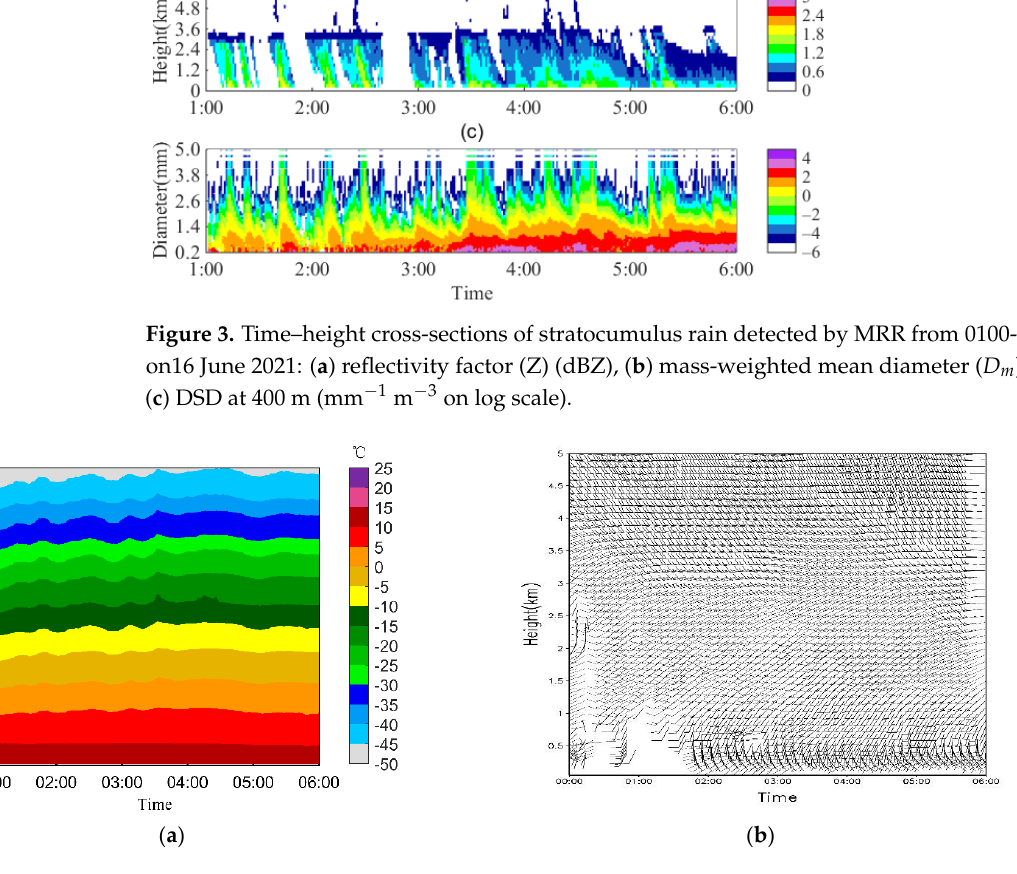
Figure 4. Time – height cross-sections of temperature ( a ) detected by MWR and wind profiles ( b ) detected by WPR from1:00 – 6:00 on 16 June 2021 in YJP station.